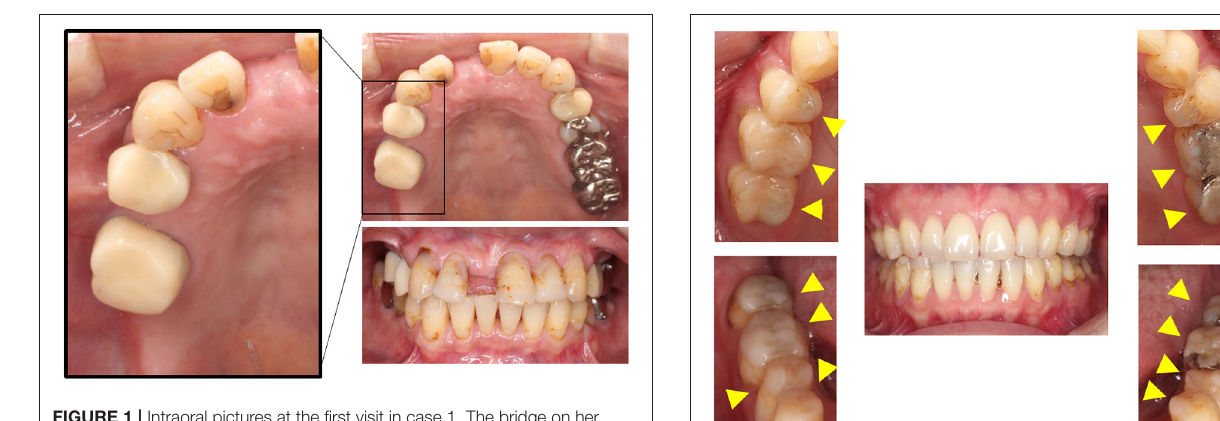
FIGURE 1 | Intraoral pictures at the first visit in case 1. The bridge on her upper right molars was removed and replaced by individual temporary crowns.